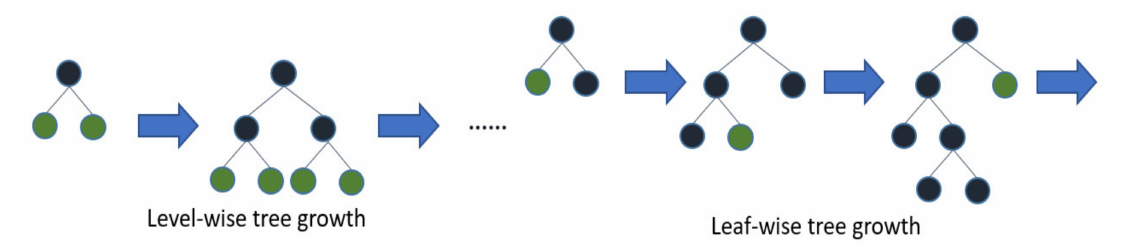
Figure 2. Level-wise vs. leaf-wise tree growth (https://lightgbm.readthedocs.io/en/latest/Features.html, accessed on 17 June